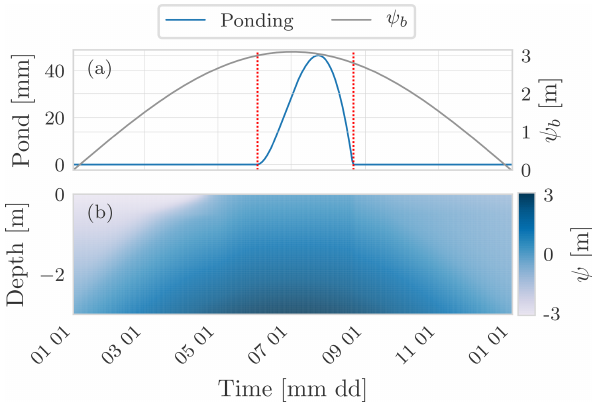
Figure C10. (a) The water table position, Dirichlet boundary condi- tion, and the water ponding at the soil surface. The dotted red lines indicate the times at which the boundary condition at the soil sur- face should be switched. The first line indicates the switch from the Neumann type to the Dirichlet type since water starts building up. The second line indicates the switch form the Dirichlet type to the Neumann type because there is no water at the soil surface. (b) The time evolution of the water suction within the soil.